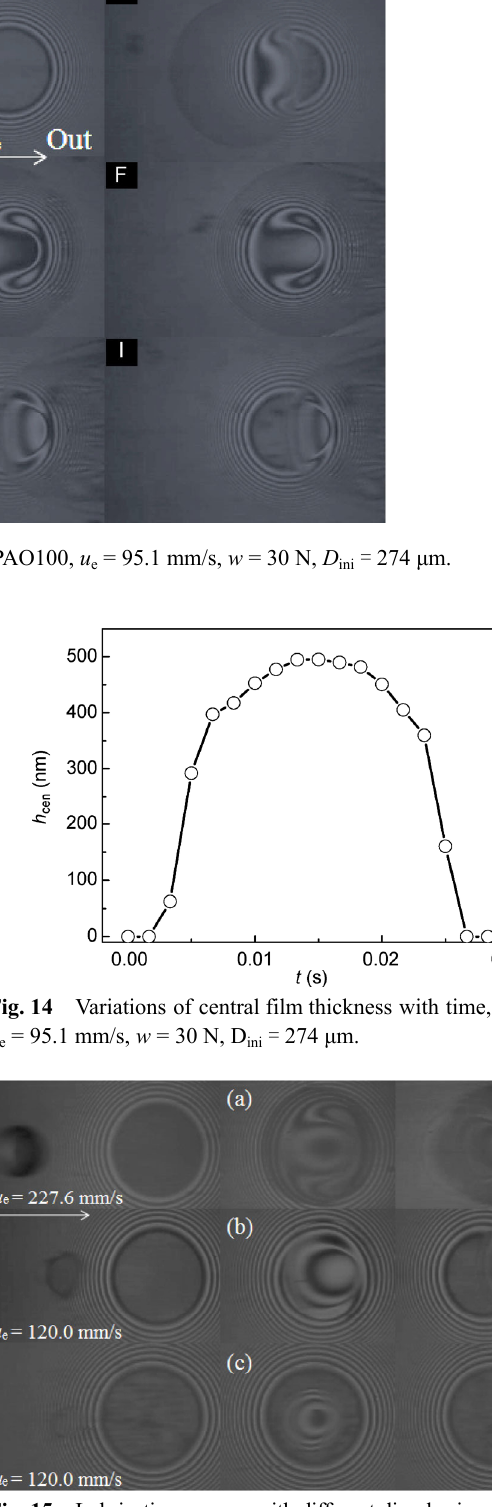
Fig. 13 Film profiles with droplet passing through the contact region, PAO100, u e = 95.1 mm/s, w = 30 N, D ini = 274 μ m.